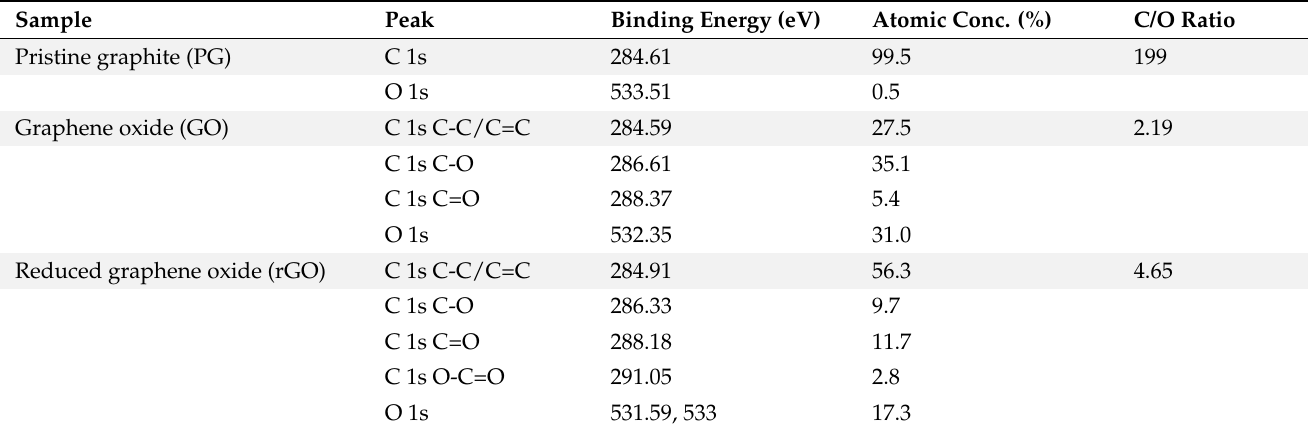
Figure 2. XPS survey spectra of pristine graphite (PG), synthesized graphene oxide (GO), and synthesized reduced graphene oxide (rGO). Spectra have been offset for clarity. Table 2. XPS compositional analysis and quantitative peak fittings of C 1s and O 1s